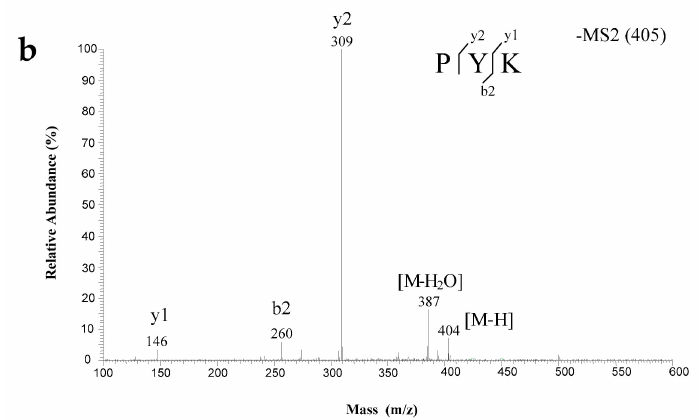
Figure 3. ( a ) Mass spectrum of the chromatographic peak A4 in Figure 2a; ( b ) MS / MS spectrum of ion m / z 405.